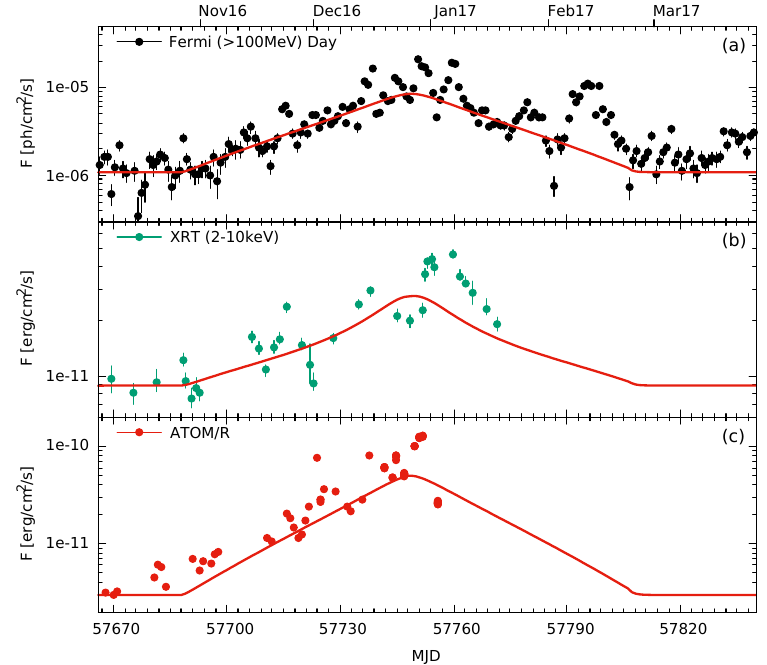
Figure 3. Model light curves (red curves) using a leptonic model within the broad-line region (BLR) for the γ -ray, X-ray and R-band [9].